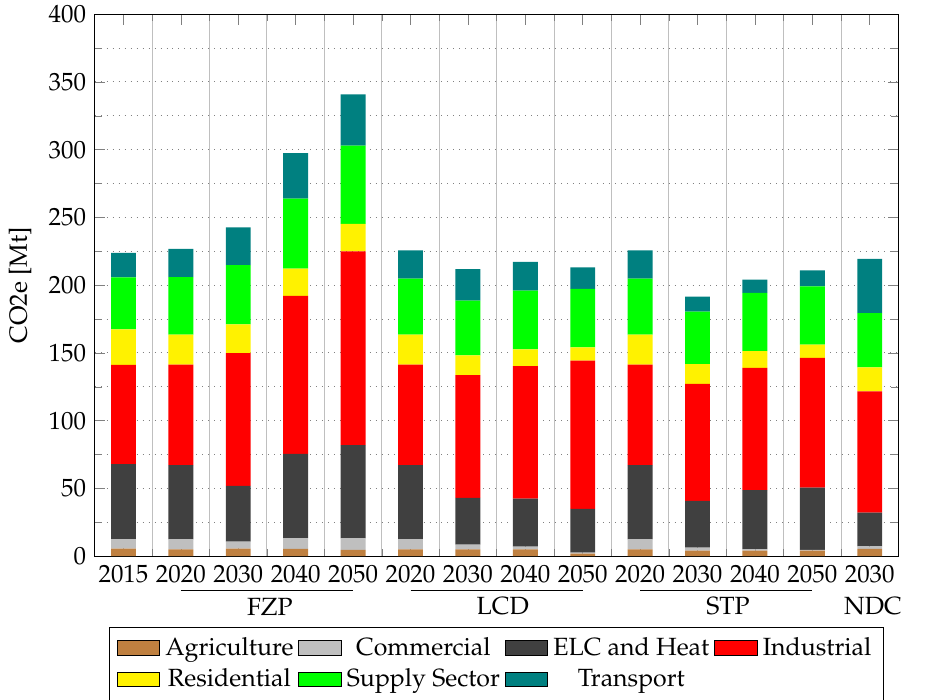
Figure 9. GHG emissions from Energy and Industrial process and product use for three main scenarios.